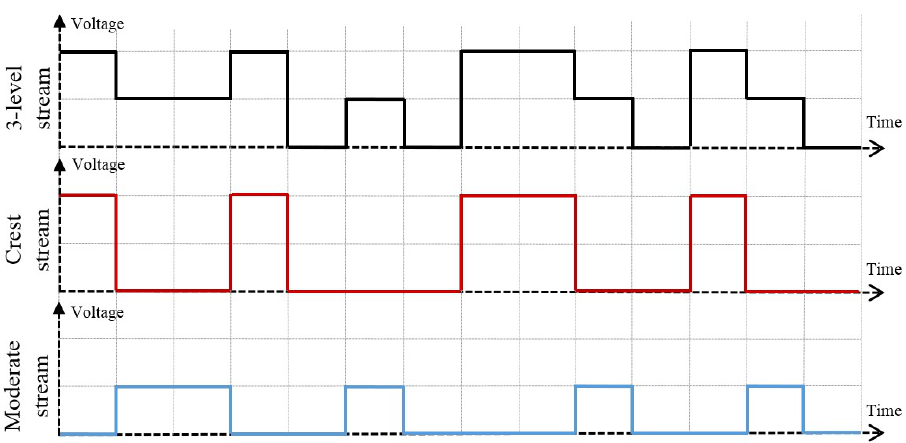
Figure 4. Time-domain decomposition of the three level-signals.